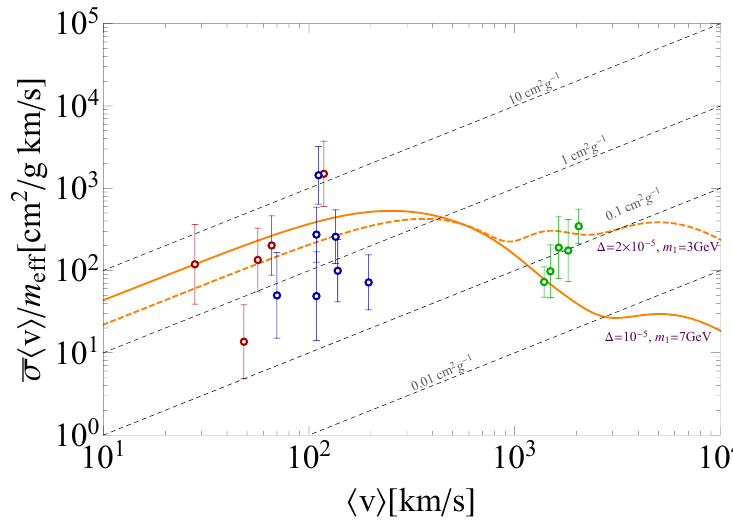
Figure 3 . Self-scattering cross section per dark matter mass for s -wave elastic scattering, φ 1 φ 2 → φ 1 φ 2 , as a function of h v rel i . We chose ∆ = 10 − 5 , 2 × 10 − 5 and m 1 = 7 , 3 GeV in orange solid and dashed lines, respectively. We took α = g 2 / (4 π ) = 0 . 1 and m eff = 2 m 1 (1 + b )